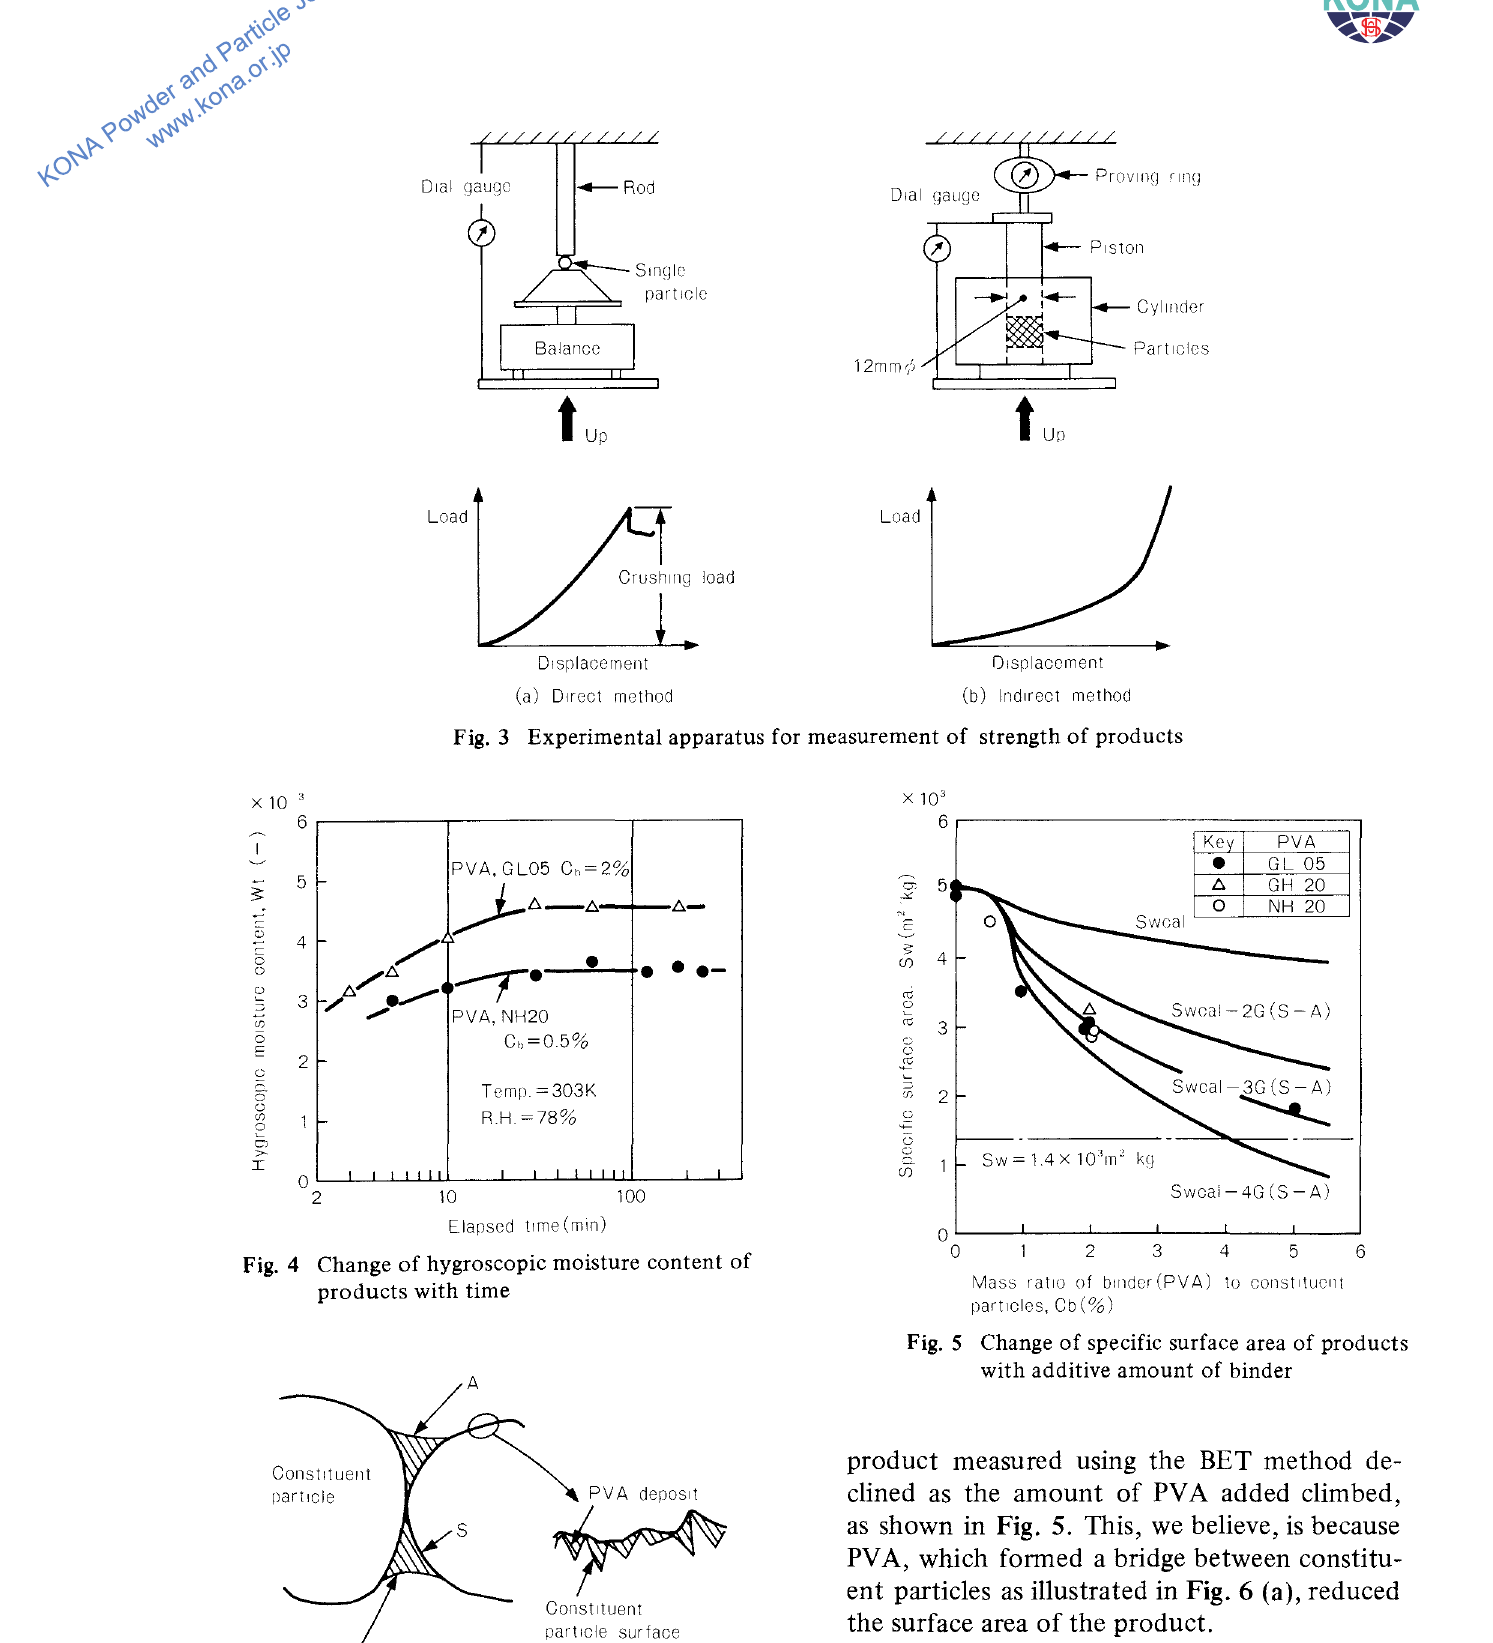
Fig. 6 Model showing PV A deposit around contact point and on constituent particle surface